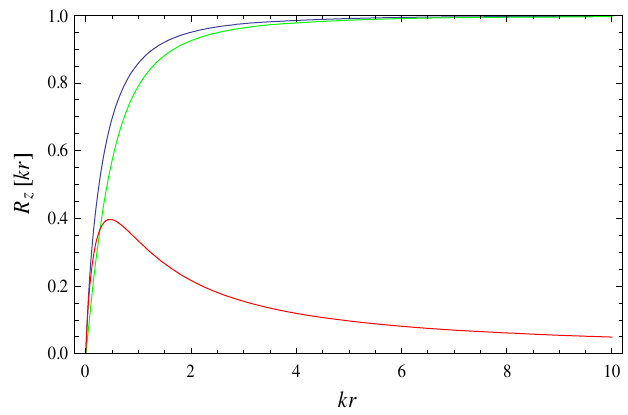
FIG. 1. Absolute value of the radial wave impedance R z versus normalized frequency kr in blue, with real part in green and imaginary part in